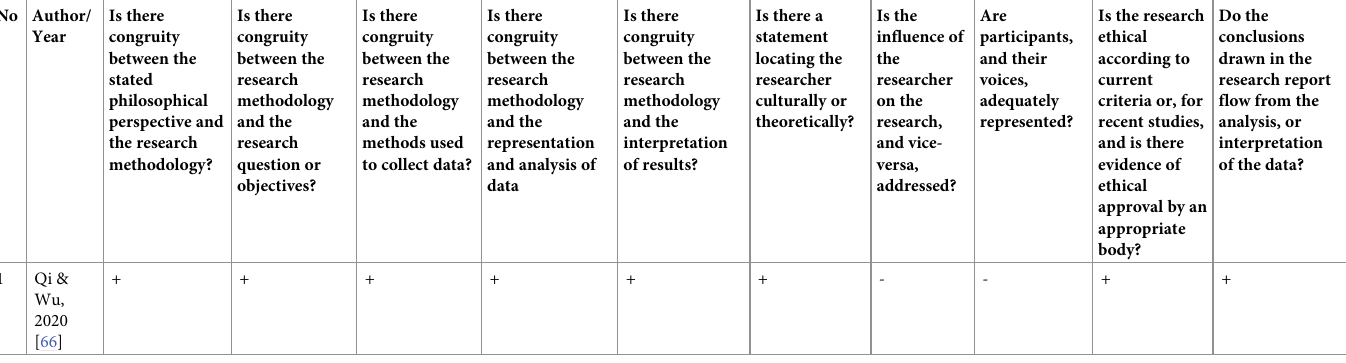
Table 3. A Checklist for qualitative research critical appraisal—Joanna Briggs Institute analytical tool.